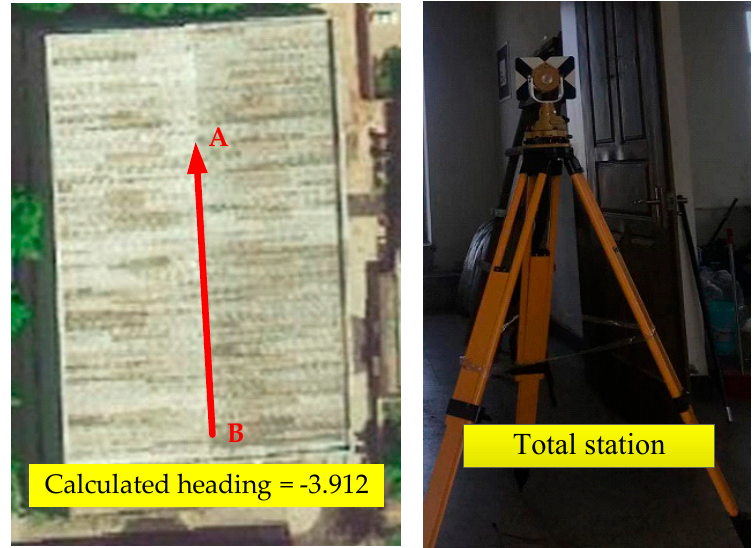
Figure 10 ． The heading of the corridor. Figure 10. The heading of the